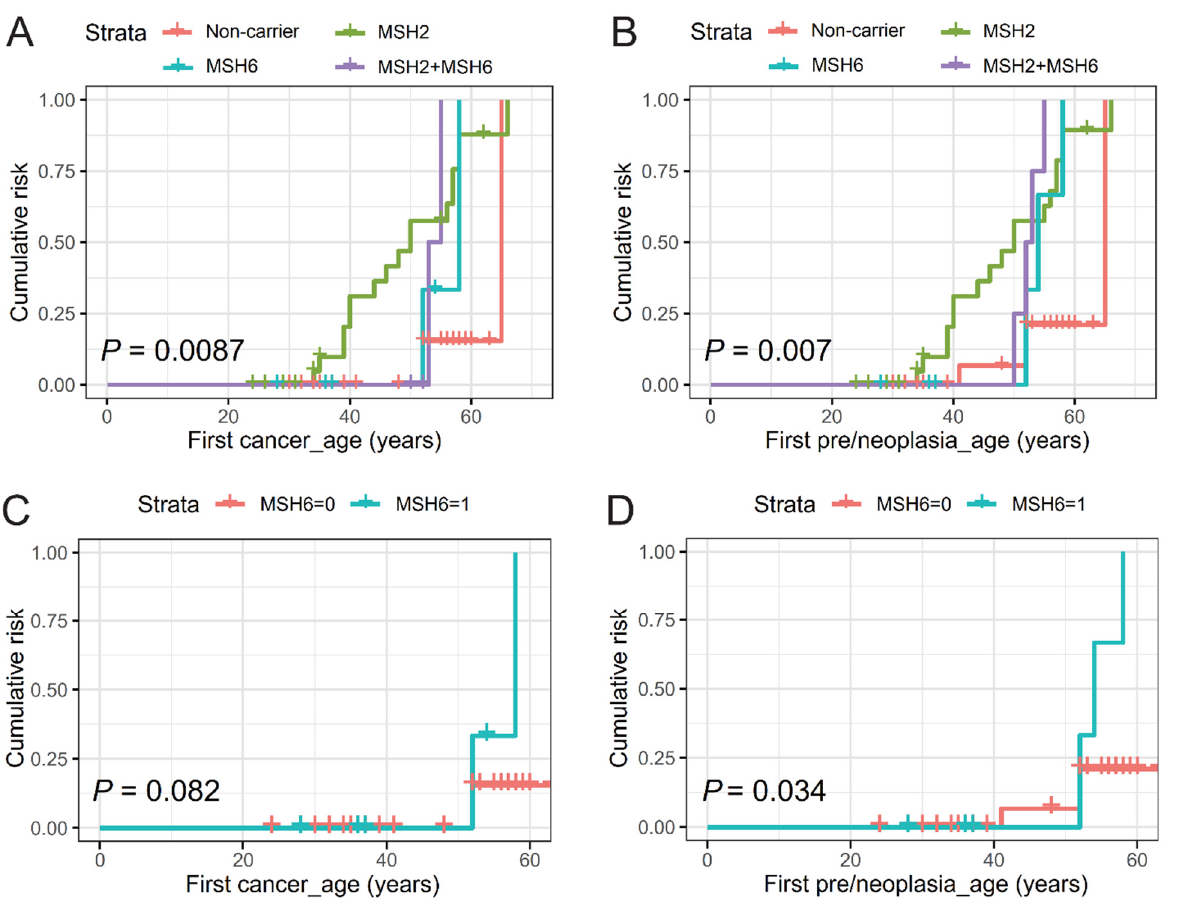
Figure 3. Risk for onset of cancer or pre/neoplasia among confirmed or obligate carriers of MSH2 c.2006G>T, MSH6 c.3936_4001+8dup (intronic), or both variants, and non-carriers of either variant. Kaplan–Meier curves are shown of risk by age in years for ( A , C ) onset of first cancer of any type, and ( B , D ) for onset of first cancer of any type and first colorectal polyp(s) pooled (pre-/neoplasia). For ( A , B ), colored lines represent carrier status for the mismatch repair variants; red, carriers of neither variant; green, MSH2 c.2006G>T alone; teal, MSH6 c.3936_4001+8dup (Intronic) alone; purple, carriers of both variants. For ( C , D ), MSH6 = 0 (red) shows non-carriers of either MSH2 or MSH6 variant ( n = 27), and MSH6 = 1 (teal) shows carriers of MSH6 c.3936_4001+8dup (Intronic) alone ( n = 7). p -values between groups were obtained by log-rank test.